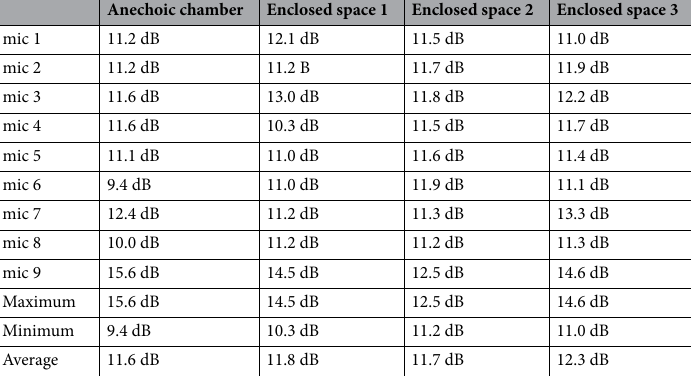
Table 2. Average reduction at each microphone in the frequency range of interest and their maximum, minimum, and average in each space. Nine microphones were placed according to KS C IEC 60704-1: